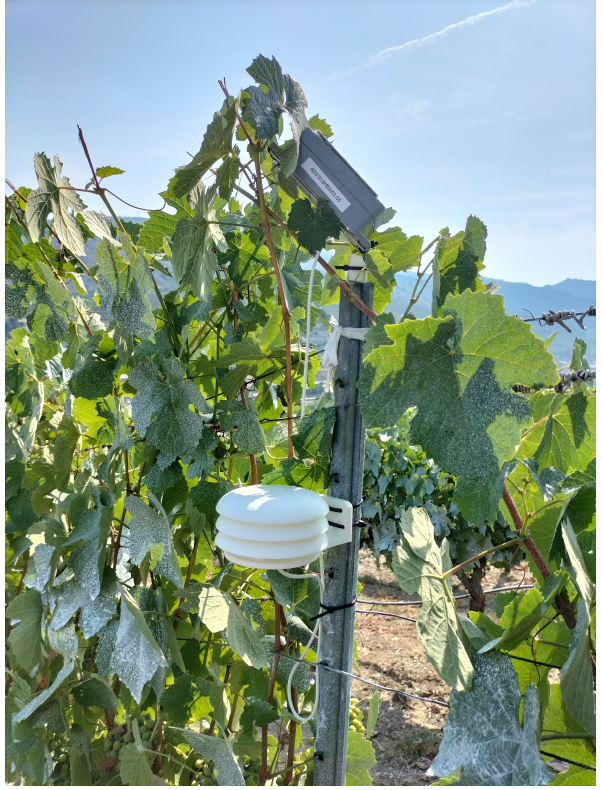
Figure 15. Example of the 3D-printed BME680 sensor